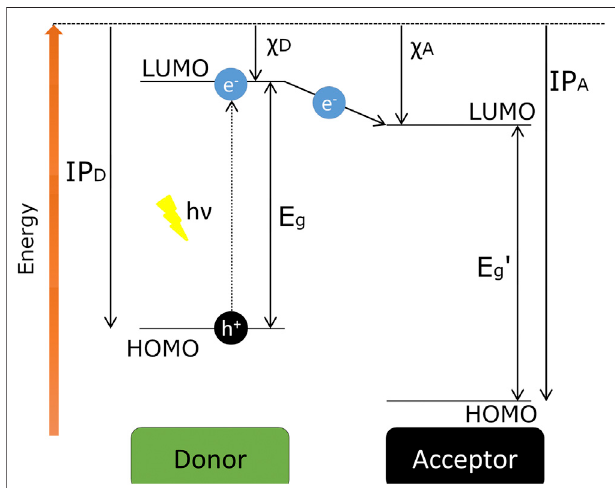
FIGURE 6 | Representation of the energy levels diagram of a donor- acceptor system, where IP is the ionisation potentials, χ is the electron af fi nity, and E g is the bandgap energy. The arrow between the LUMO levels indicates the photoinduced ET, which is the fi rst step for generating free charge carriers. Adapted from Reference Scharber and Sariciftci